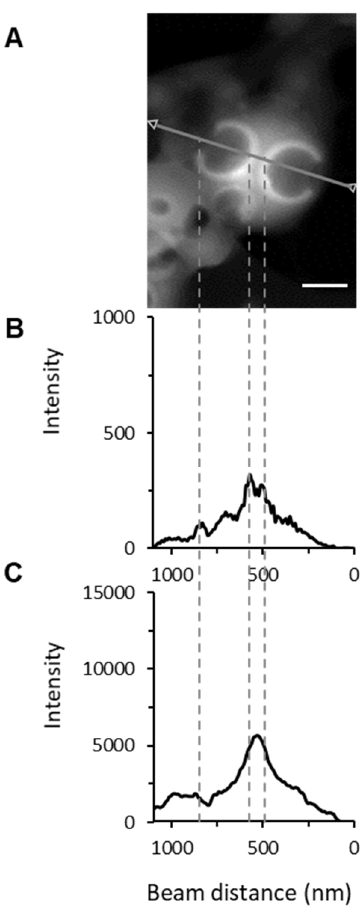
Figure 9. ( A ) STEM image of VCM-loaded PLGA 15 C NPs, EDX line scanning profiles on ( B ) the elemental mapping of the nitrogen and ( C ) of the carbon. The higher values of the nitrogen intensity are indicated by the dashed lines. Scale bar is 250 nm.